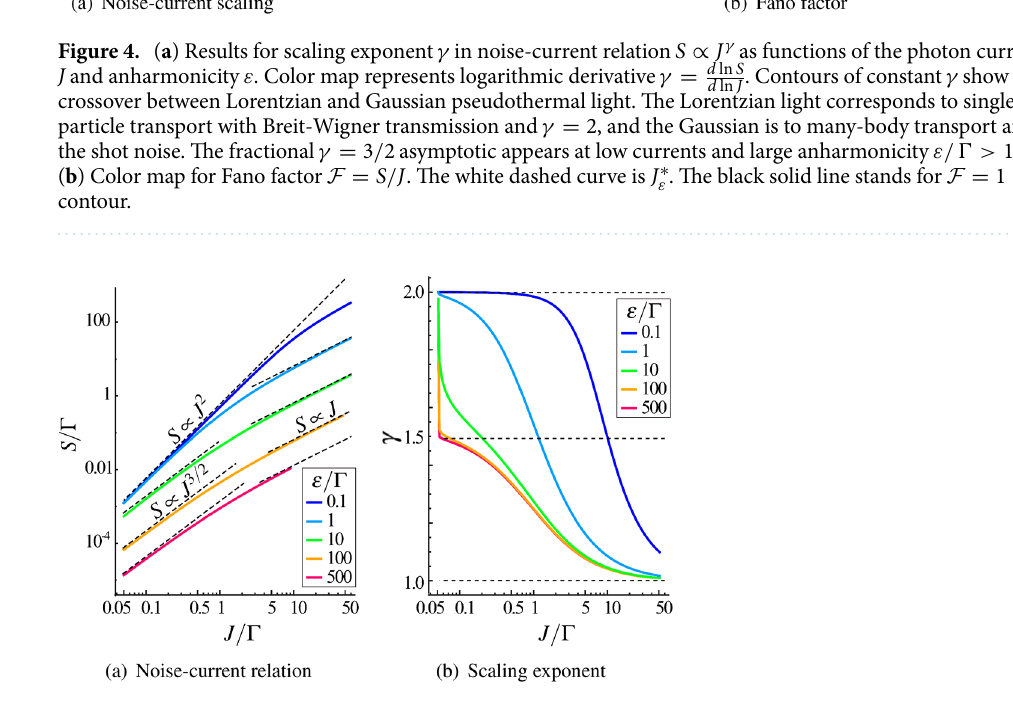
Figure 5. ( a ) Noise-current relation S 10, 100, 500) anharmonicity (Bose-Hubbard interaction strength). The logarithmic scale demonstrates three different regimes of the photon transport: quadratic thermal behavior at weak interaction, and fractional power- J 3 / 2 at small currents that changes to conventional shot noise S law S ∝ γ that demonstrates a change of fixed point from γ